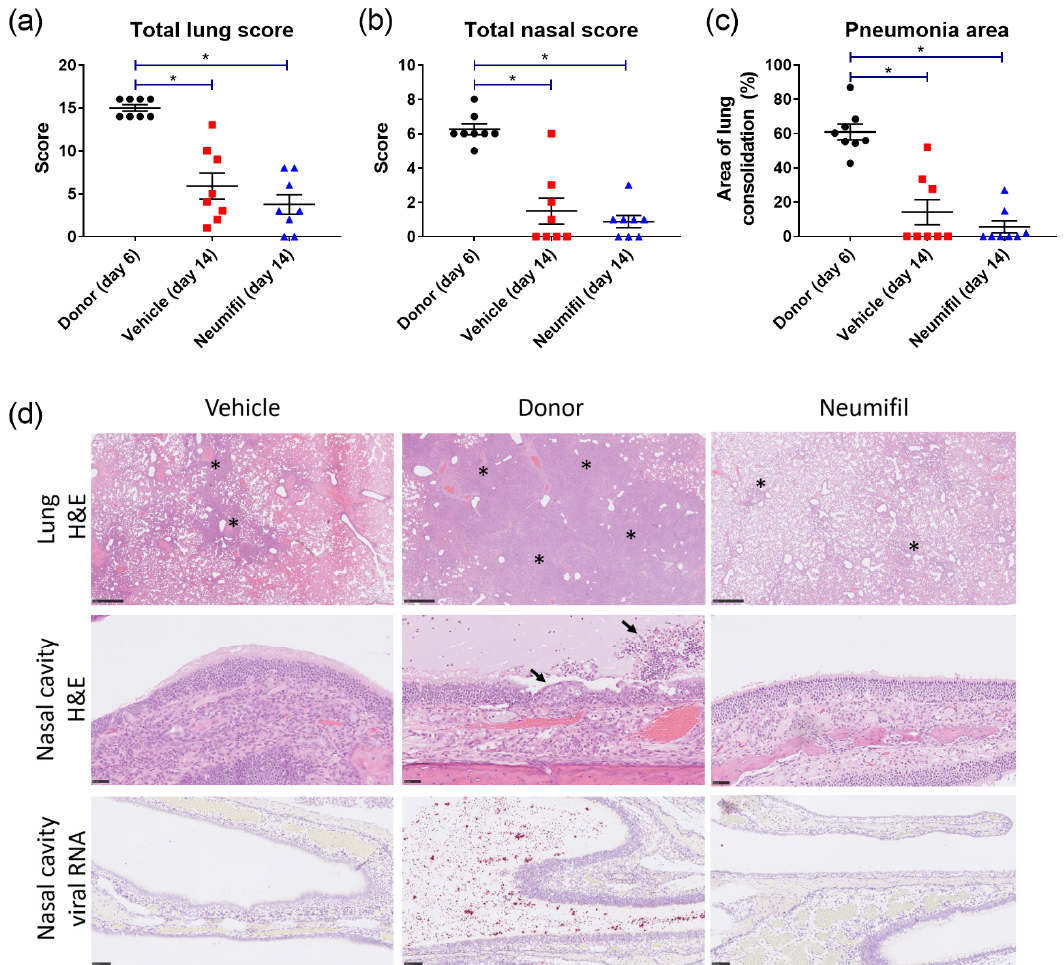
Figure 4. Histological readouts from donor or recipient animals treated with either Neumifil or vehicle after challenge with SARS-CoV-2. Total histopathology scores for ( a ) lung and ( b ) nasal cavity. ( c ) Percentage of area with consolidation (pneumonia) in the lung as determined by image analysis. ( a – c ) Individual animals are shown as a symbol, with line and whisker plots indicating the mean and standard error. *, p < 0.05. ( d ) Representative microscopic images of lung consolidation (top row, indicated by asterisks), changes in nasal cavity mucosa (middle row) and standard for SARS-CoV-2 RNA in the nasal cavity (lower row). Scale bars represent 1 mm (top row), 50 µm (middle row) and 100 µm (lower row).